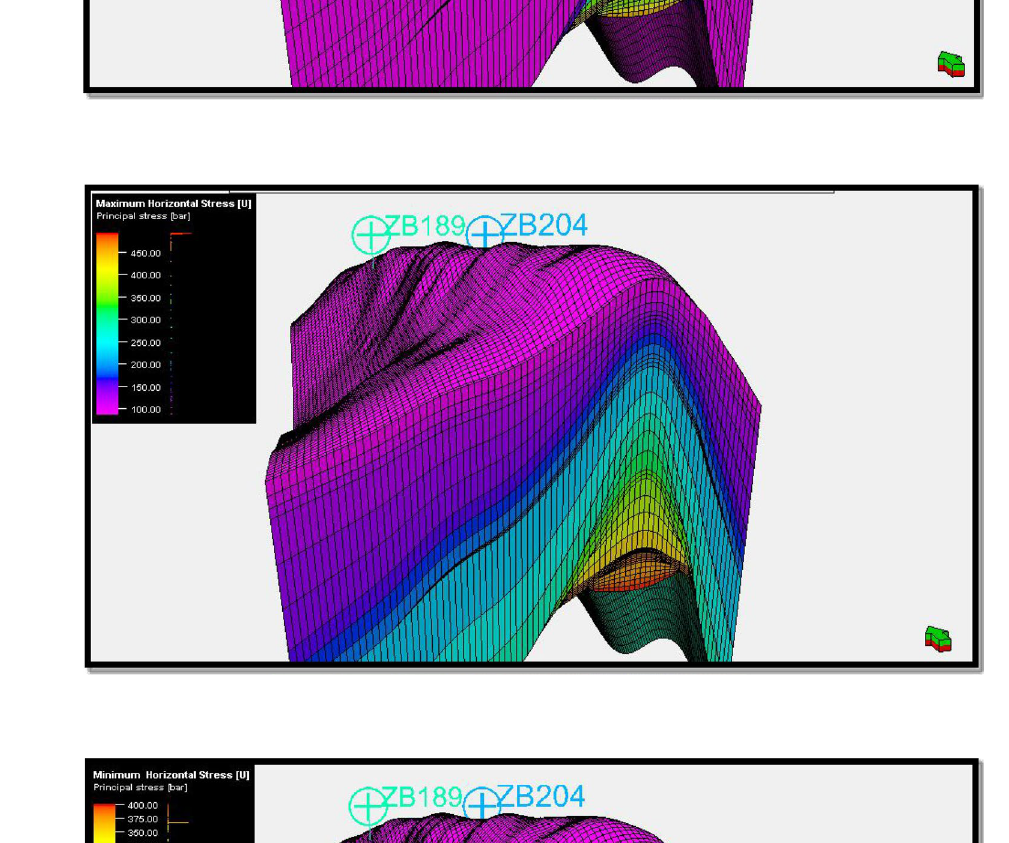
Fig. 23 Minimum horizontal